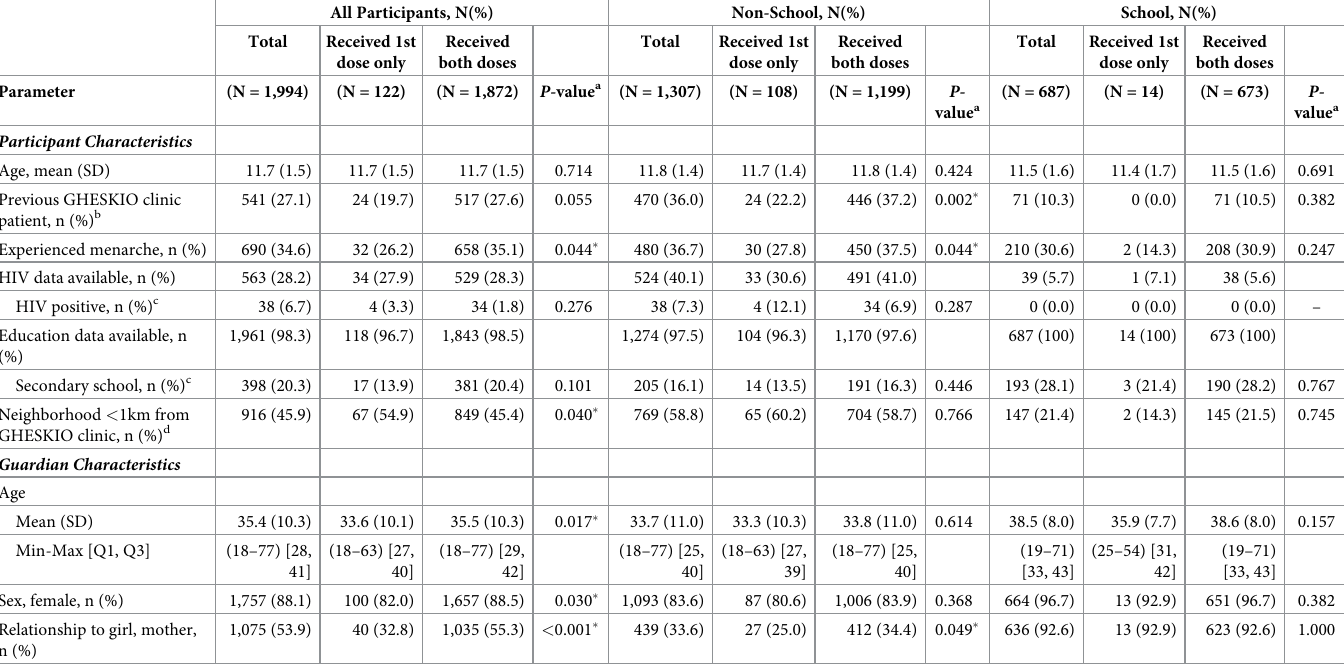
Table 1. Characteristics of participating adolescents with at least 1 dose of HPV vaccine and their guardians, overall and by cohort. All Participants, N(%)